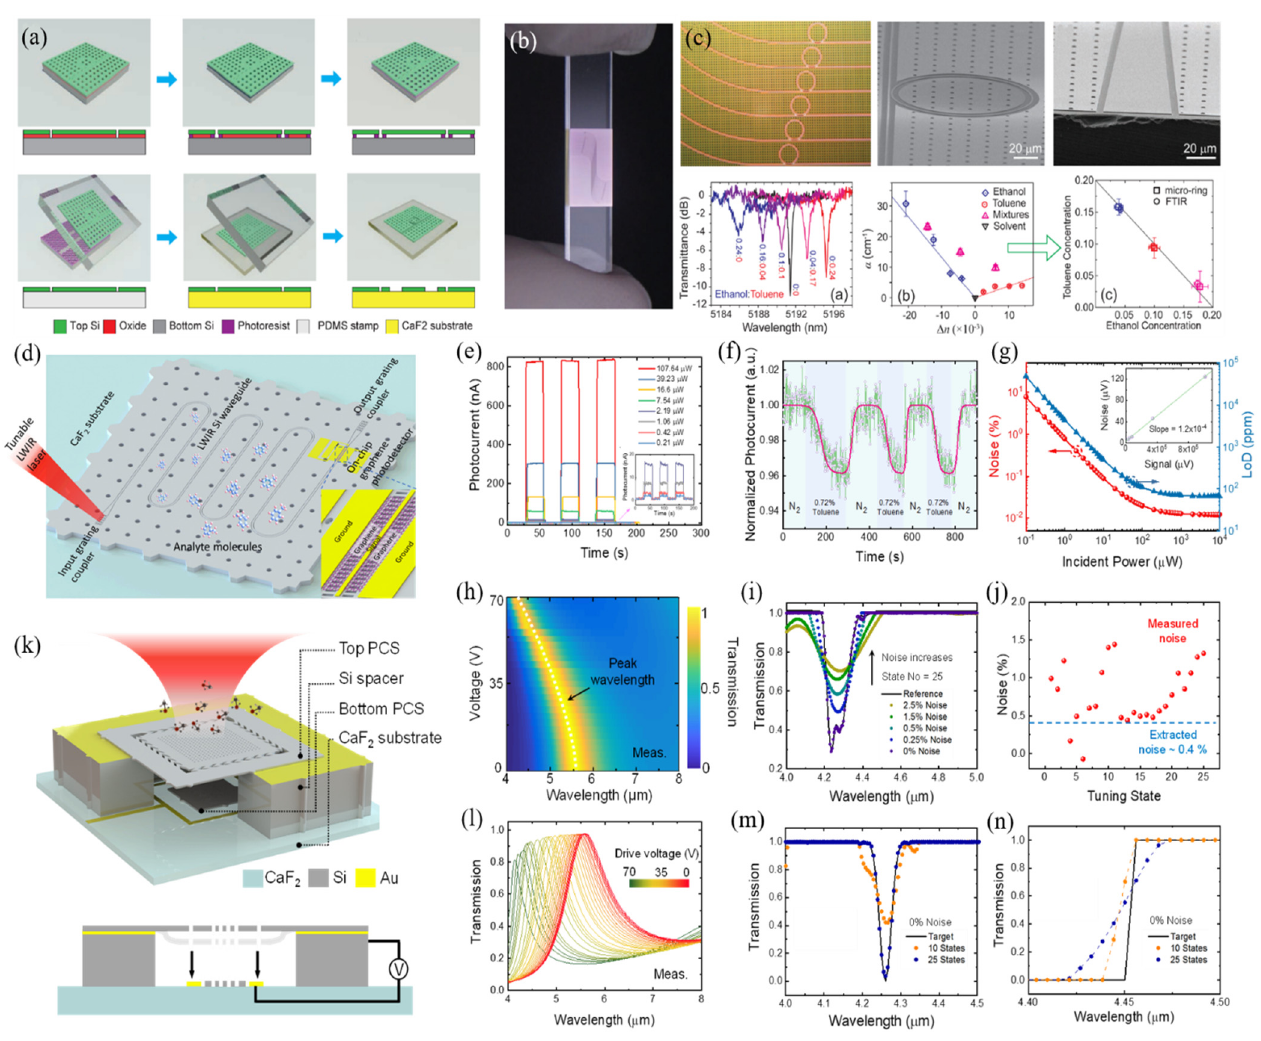
Figure 7. Si thin-film transfer onto the CaF 2 substrate for the MIR sensing applications. ( a ) Schematic illustration of the Si thin film transfer process [173]. ( b ) Optical image of the fabricated Si photonic device on a CaF 2 substrate [173]. ( c ) Optical and SEM images of the fabricated microring sensors with their performance test [173]. ( d ) Schematic illustration of the heterogeneously integrated graphene/Si/halide Si-based MIR photodetectors [174]. ( e – g ) Dynamic on-chip sensing demonstration [174]. ( h – j ) Simulation and experimental results for the spectral tuning and gas sensing [175]. ( k ) Schematic diagram of the MEMS-based tuning optical gas sensor [175]. ( l – n ) Simulation and experimental results for the spectral tuning and gas sensing. Reprinted with permission from ref. [173]. Copyright 2014 American Chemical Society.Reprinted with permission from ref. [174]. Copyright 2021 American Chemical Society. Reprinted with permission from ref. [175]. Copyright 2021 Institute of Electrical and Electronics Engineers.